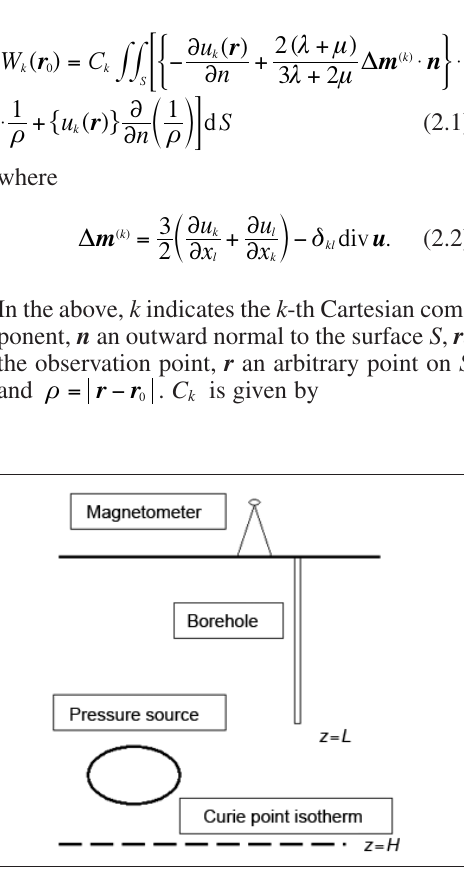
Fig. 1. Schematic representation of a borehole, a pressure source and the magnetized